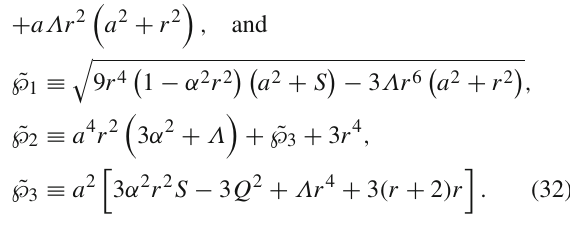
Fig. 11 Metric bundles of the double extreme RN BHs , with metric components given in Eq. (33) and θ = π/ 2 in the plane r − M 1 (left panel), r − M 2 (center panel) and ( r − b ) (right panel). ( M 1 , M 2 ) are the two BH mass parameters, b is the BHs (radial) distance, ω is the bundle